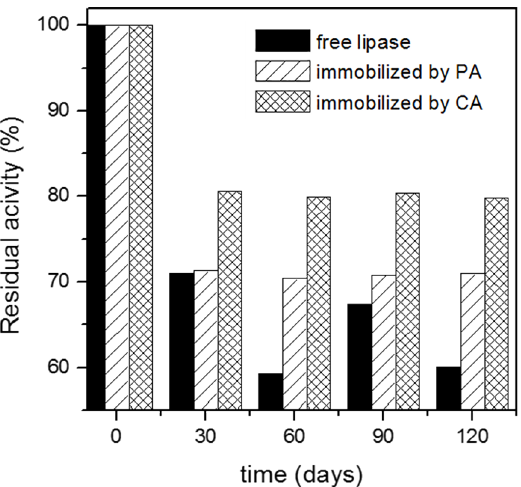
Figure 8. Storage stability for: (black) free lipase, (striped) lipase immobilized by physical absorption (PA), and (plaid) lipase immobilized by covalent attachment